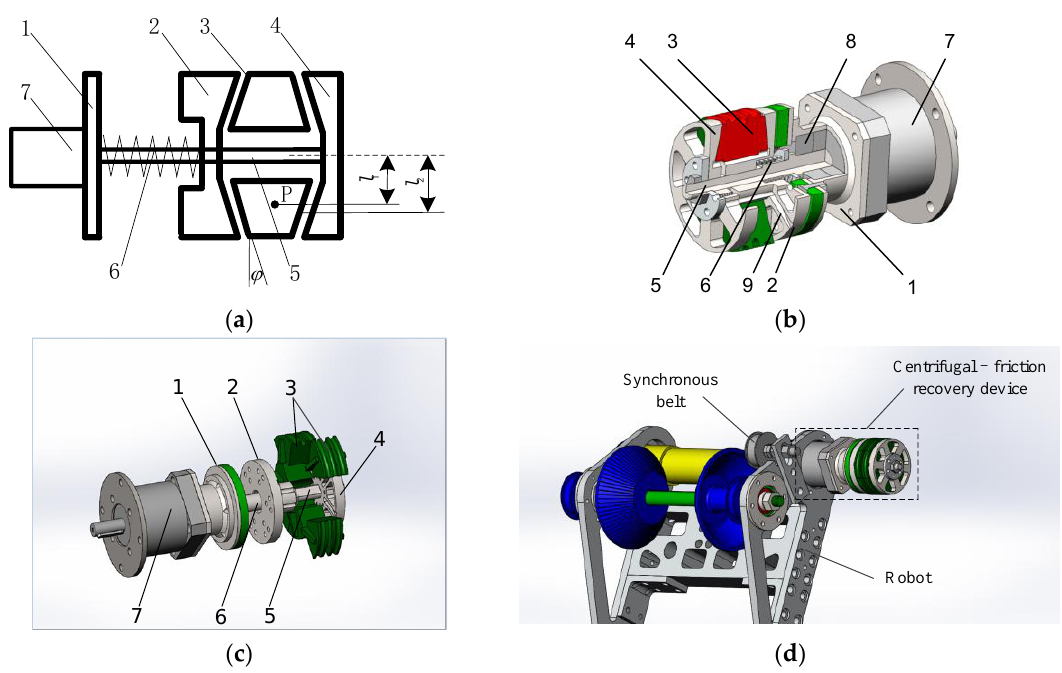
Figure 3. Safety recovery structure of the robot. 1—Main case; 2—Brake disc; 3—Mass blocks; 4—Base; 5—Rotary shaft; 6—Spring mechanism; 7—Gearbox; 8—Ball bearing; 9—slideway. ( a ) Schematic diagram of recovery mechanism; ( b ) The inner structure of the recovery device; ( c ) Breakdown drawing of recovery mechanism; ( d ) Centrifugal–friction recovery mechanism.